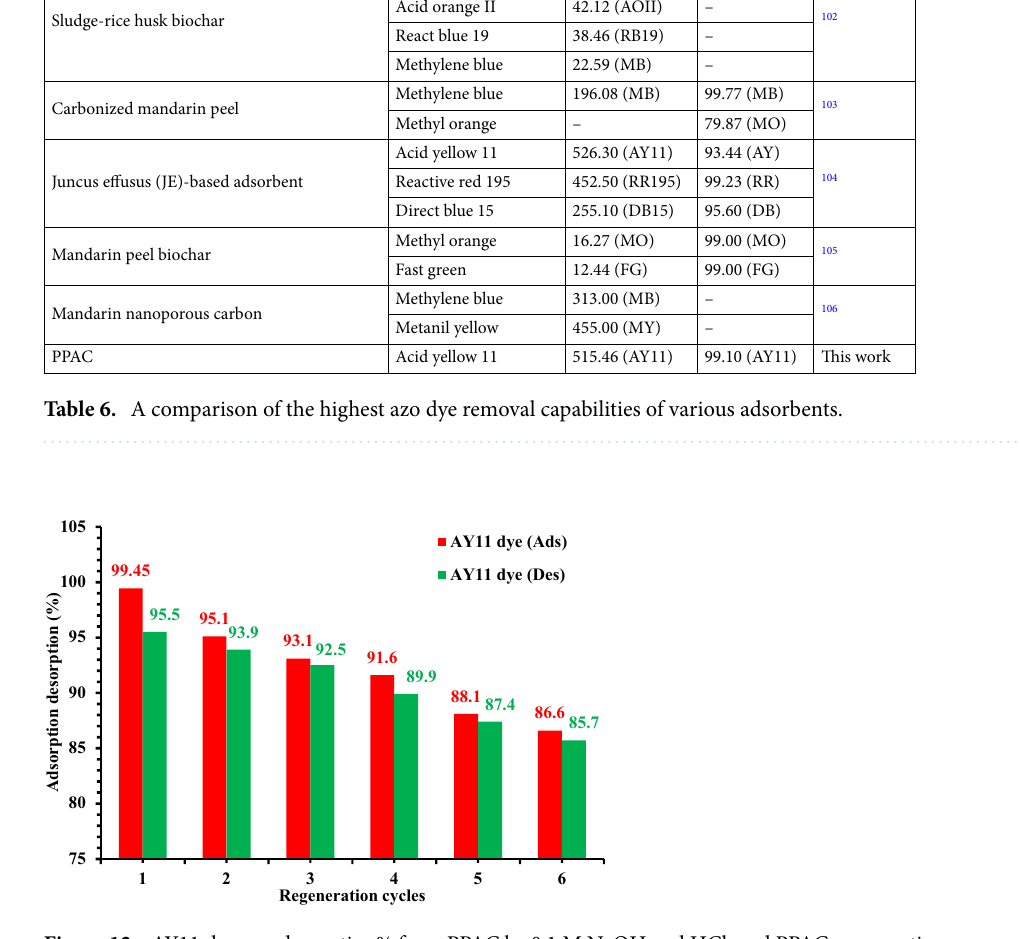
Figure 12. AY11 dye was desorption% from PPAC by 0.1 M NaOH and HCl, and PPAC regeneration was used to promote AY11 dye adsorption